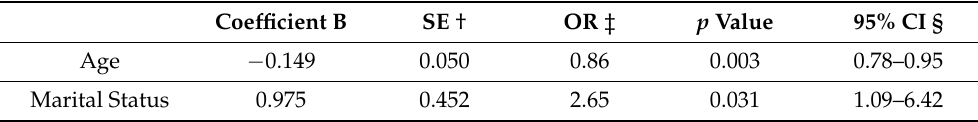
Table 2. Factors Associated with Vaccination Completion (Completers vs. All Other Groups) among Student Nurses.